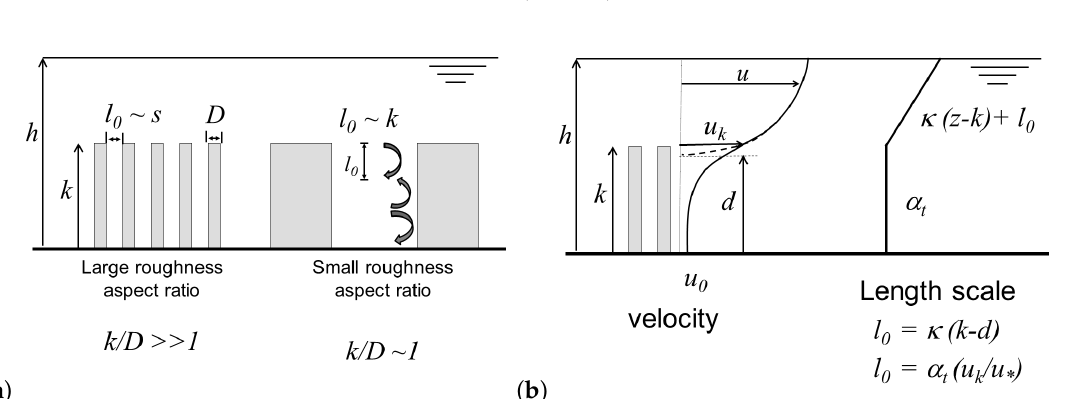
Figure 2. Turbulent length scale as a function of canopy aspect ratio ( a ) and vertical profile of velocity and turbulent scale for submerged flow ( b ).